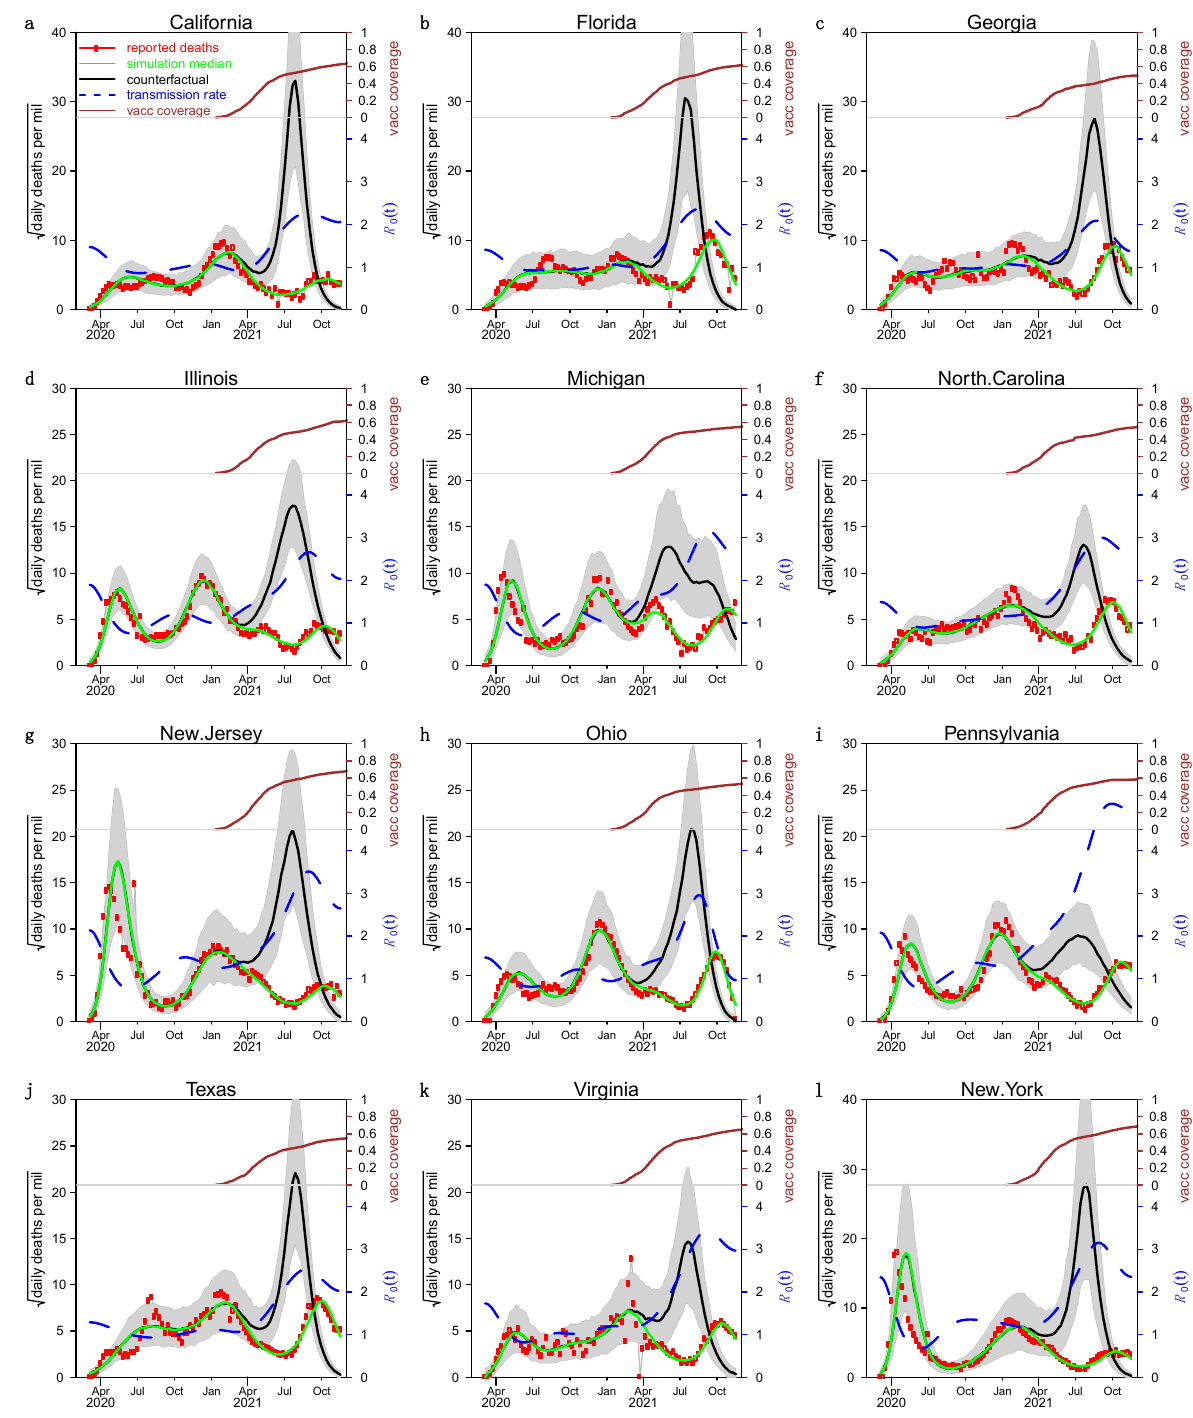
Figure 3. Fitting results under case 2. Panels ( a – l ) sowed the model fit for the 12 most populous states in the US applying the second approach, respectively. Others are the same as Figure 2.